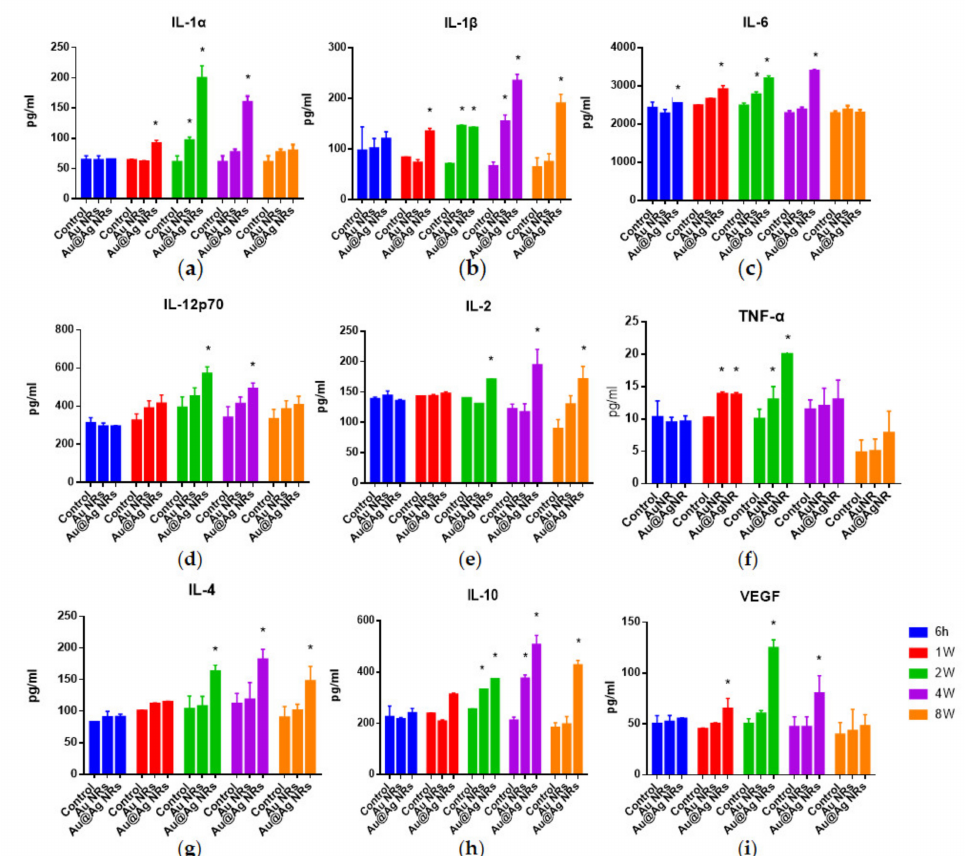
Figure 3. Cytokine and grow factor detection in serum. At 6 h, 1 w, 2 w, 4 w and 8 w after administration, the concentrations of IL-1 α ( a ), IL-1 β ( b ), IL-6 ( c ), IL-12p70 ( d ), IL-2 ( e ), TNF- α ( f ), IL-4 ( g ), IL-10 ( h ) and VEGF ( i ) were detected in serum, respectively. * p < 0.05.